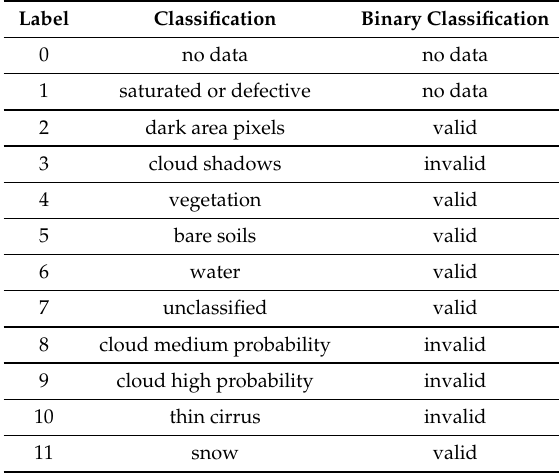
Table 4. Conversion of Sen2Cor mask classes to valid/invalid.